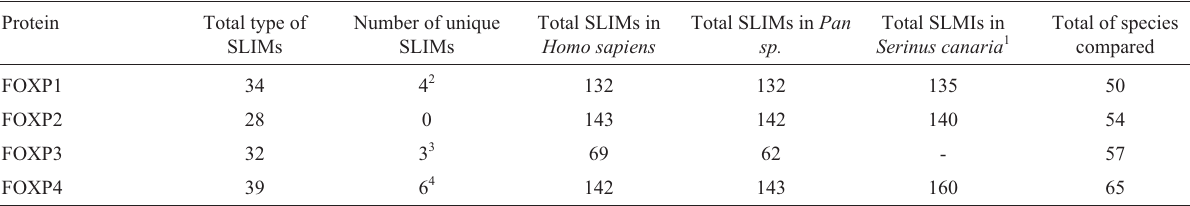
Table 5 - Number of shared and unique short linear motifs (SLIMs) among Tetrapoda FOXPs.